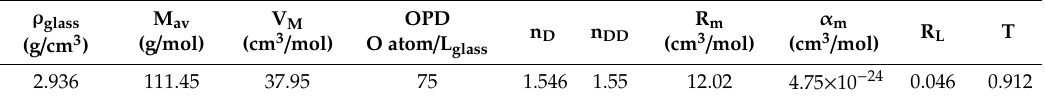
Table 1. Te-5 glass properties: glass density ( ρ glass ), molar volume (V M ), oxygen packing density